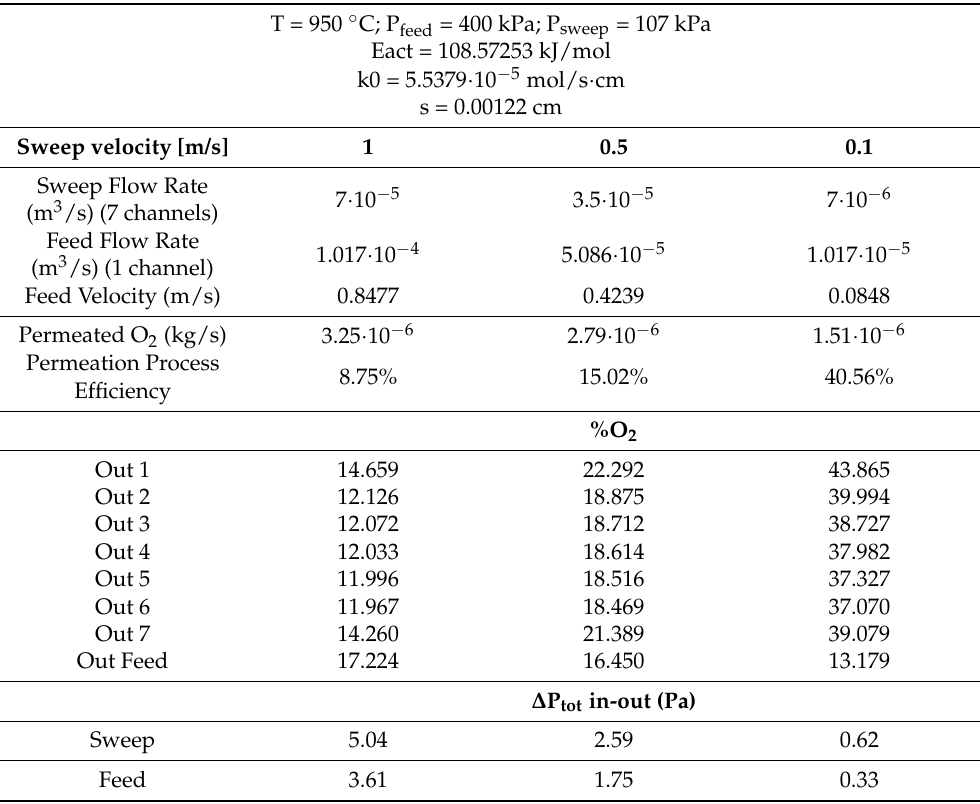
Table 6. Results of the CFD